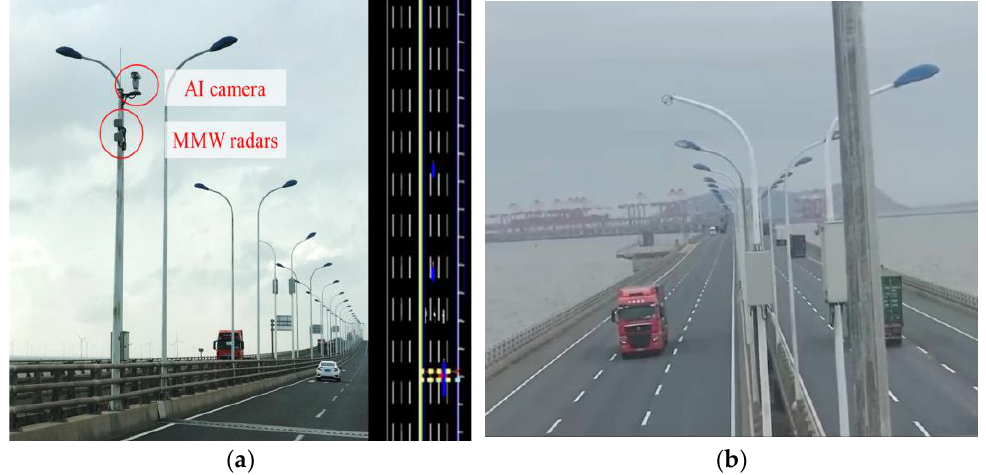
Figure 6. A real scenario of roadside perception on Donghai Bridge, Shanghai, China: ( a ) roadside MMW radar and AI cameras; ( b ) Donghai Bridge video data.